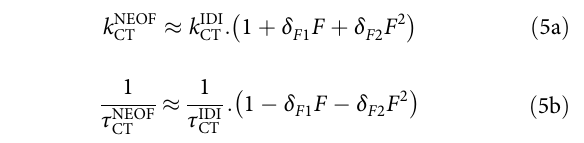
) reduces Δ G * , hence CT CT > λ ), increasing CT CT